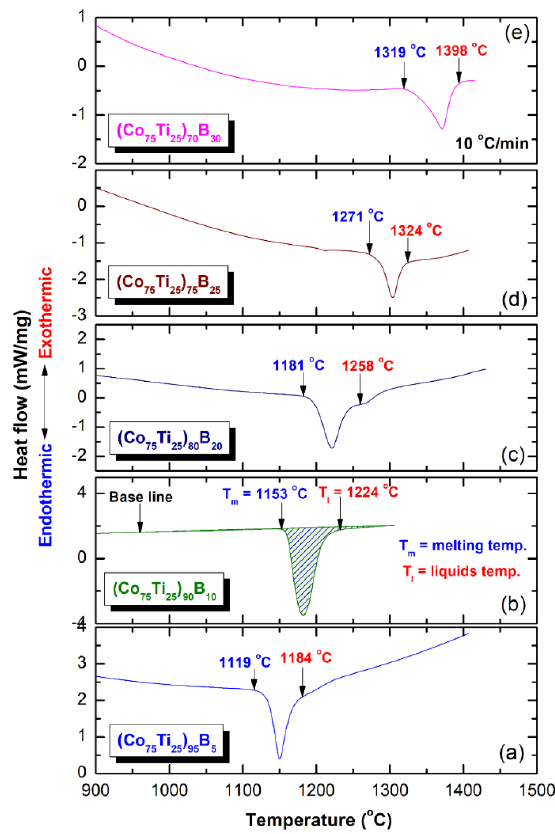
Figure 10. Traces of ( a ), (Co 75 Ti 25 ) 95 B 5 ( b ) (Co 75 Ti 25 ) 90 B 10 , ( c ) (Co 75 Ti 25 ) 80 B 20 , ( d ) (Co 75 Ti 25 ) 75 B 25 , and ( e ) (Co 75 Ti 25 ) 70 B 30 powders obtained after 50 of MA time.